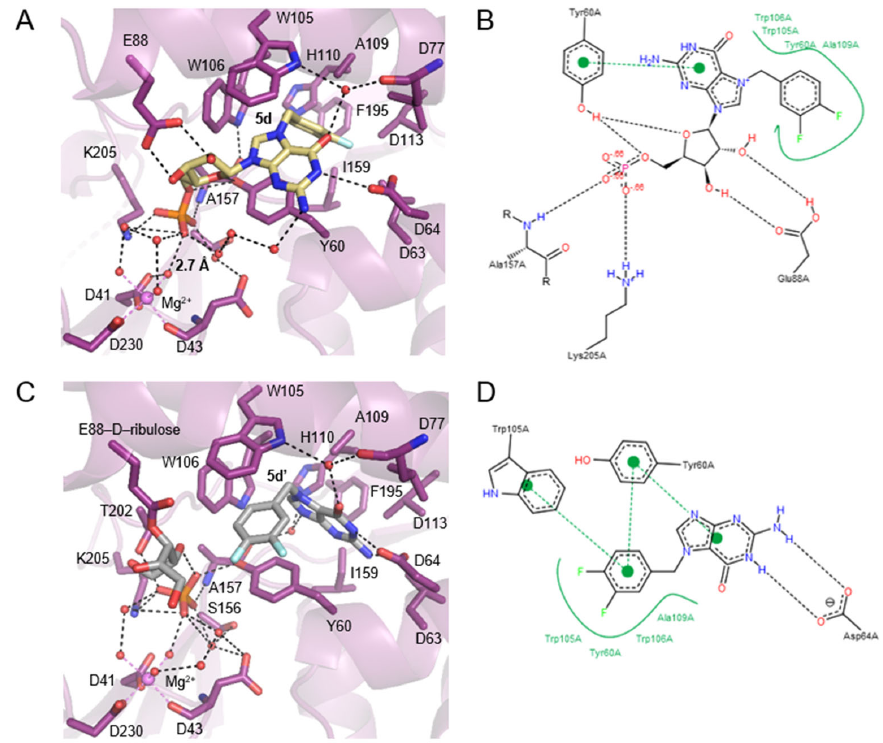
Figure 6. Structural insight into cN-IIIB inhibitor binding and close up view of interactions between 5d/5d’ and human cN-IIIB. ( A ) The structure of the enzyme in complex with compound 5d , shown in yellow carbon, obtained by soaking, while the complex structure presented in ( C ) was obtained by cocrystallization of compound 5d with the enzyme. The inhibitor 5d in ( C ) decomposed to 5d’ - N7 -(3,4-diflorobenzyl)guanine, D-ribulose, both presented in gray carbon, and phosphate. cN-IIIB is shown in a purple cartoon representation, and relevant residues are shown in sticks, where dark blue is nitrogen, red—oxygen, orange—phosphate, and light blue—fluoride. Hydrogen bonds are shown as a dashed black line, and magnesium and its coordinated bonds are marked in violet. ( B , D ). Pose view representations of interactions between ligands and cN ‐ IIIB, with hydrophobic interactions shown as a green line and hydrogen bonds shown as black dashed lines.